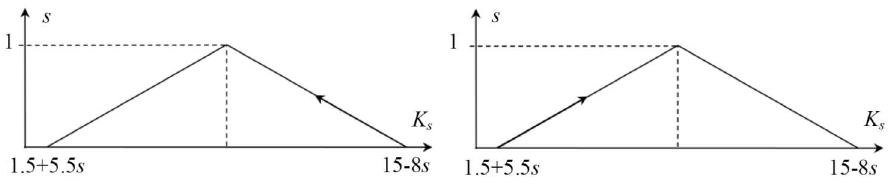
Figure 7. OFN of fuzzy storage